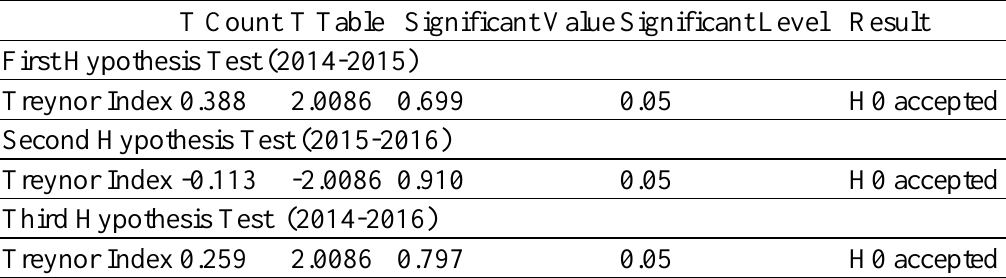
Table 11 Test Results of the First- Third Hypotheises (2014-2016) T Count T Table Significant Value Significant Level